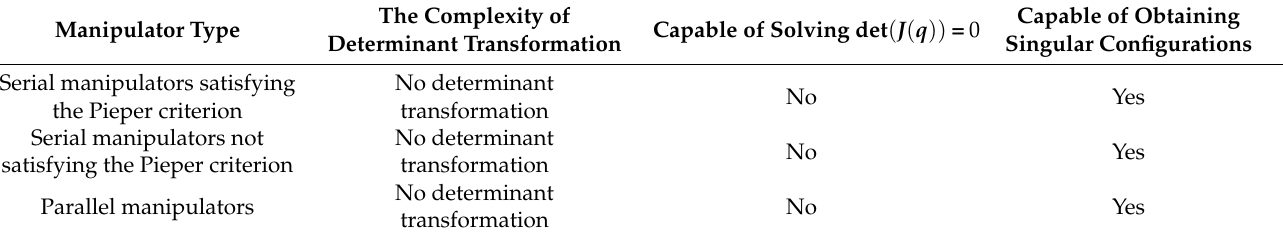
Table 5. Results for the proposed method.